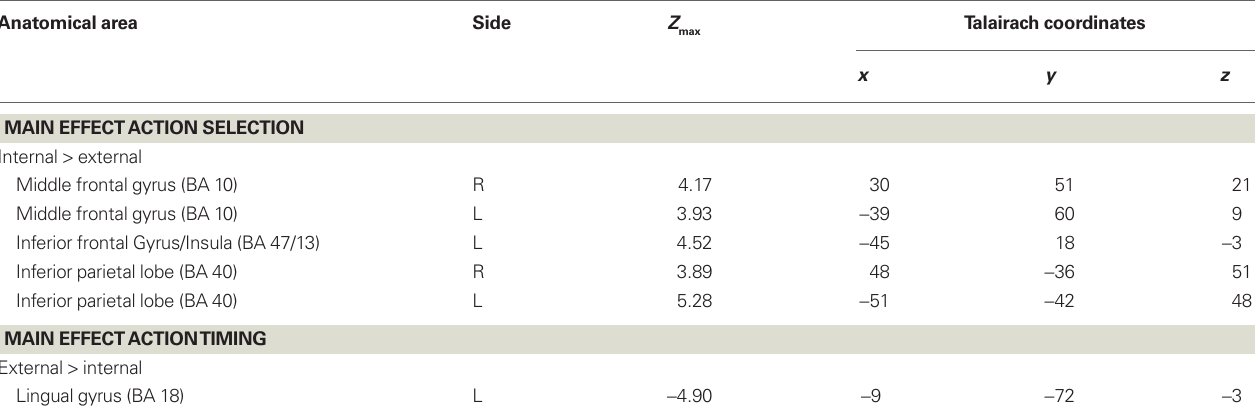
Table 2 | Anatomical location, hemisphere, maximum Z value ( p = 0.001, corrected) and Talairach coordinates. Target-related activations with a minimum cluster size of 1134 mm 3 are